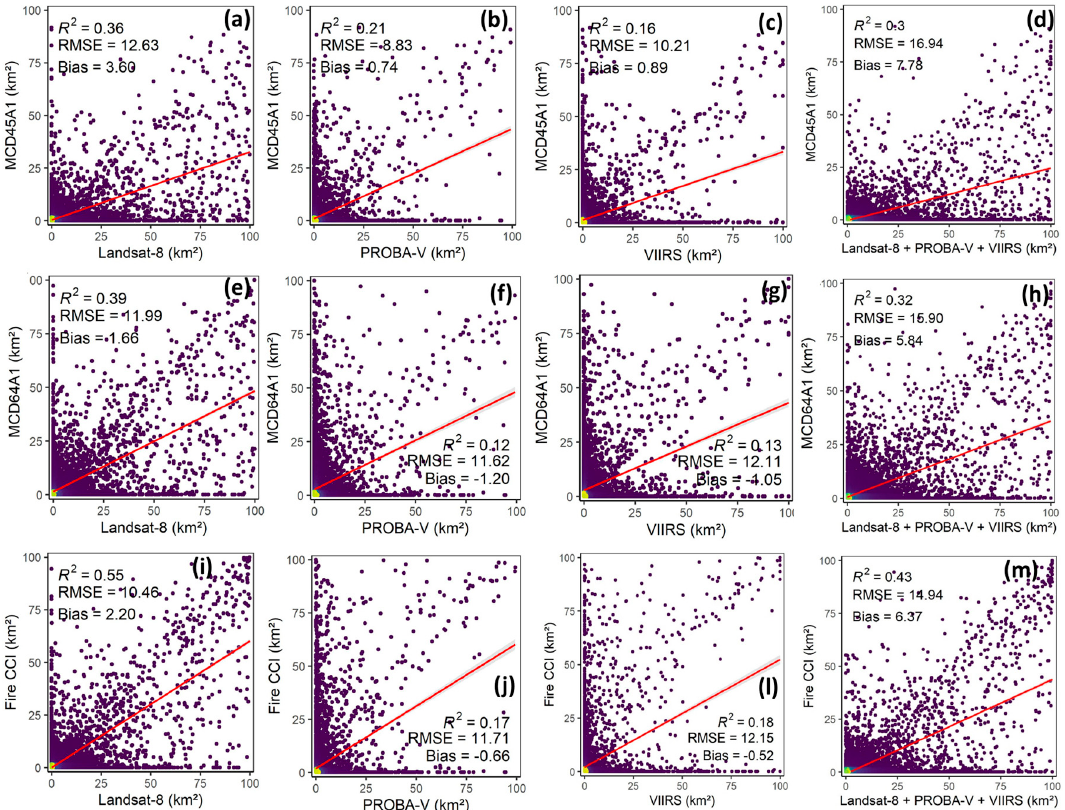
Figure 8. Scatter plots of regression by grid cells in comparison with MCD45A1 ( a – d ); MCD64A1 ( e – h ); and Fire CCI ( i – m ) with the results, considering grid cells with side dimensions of 10 km, to obtain the r 2 , root-mean-square error (RMSE), and bias, based on the maximum number of cells.